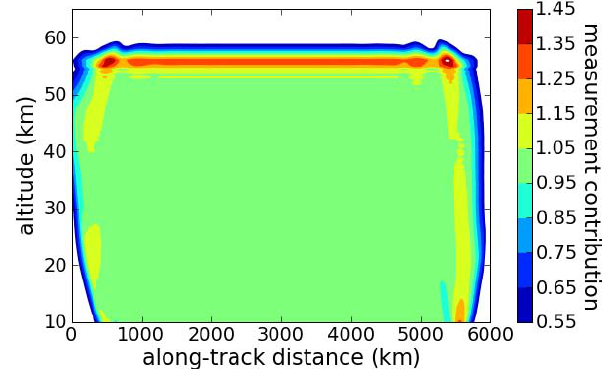
Fig. 6. Plot of the averaging kernel of a single atmospheric state vector element located in the middle of the atmosphere at 40km height. Each coloured box represents the influence of the atmo- spheric grid point of the true atmosphere on a single sample of the retrieval result. Its shape is typical for averaging kernels of elements between 15km and 50km height.